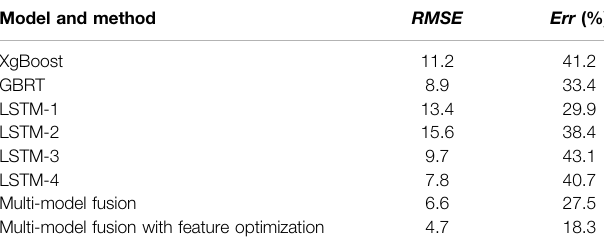
TABLE 1 | Comparison of different basic models and fusion model algorithms for emergency defective material prediction. Model and